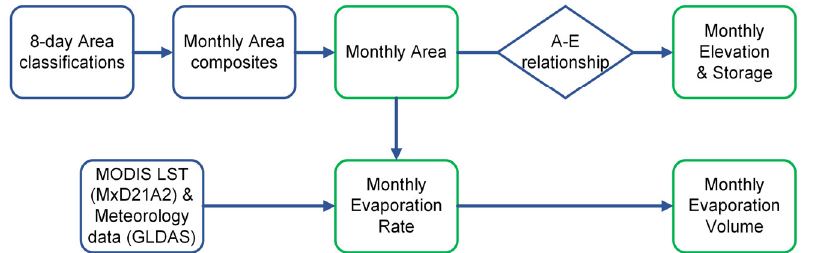
Figure 4. Flow chart of the algorithm for deriving the MxD28C3 product, which contains monthly area, elevation, storage, evaporation rate, and volumetric evaporation loss results for the 164 reservoirs. The green boxes represent the product components.